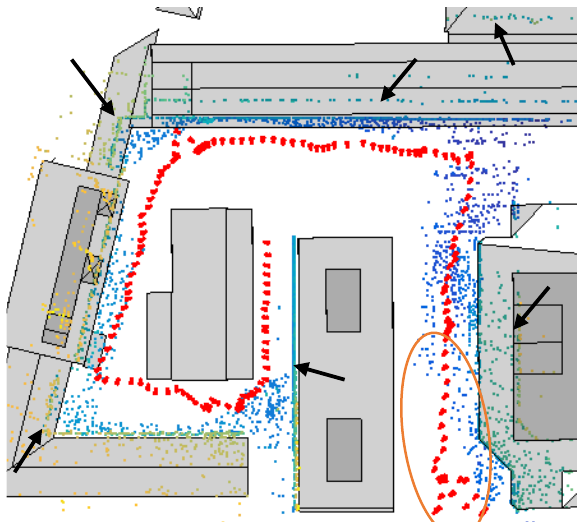
Figure 2: Result of step 2 for a 150 m by 120 m building complex: LOD2 model (grey), camera poses (red), tie points color coded by height from blue (low) to yellow (high). Differences of the tie point cloud to the model are highlighted by black arrows. GNSS was used only within the orange ellipse.